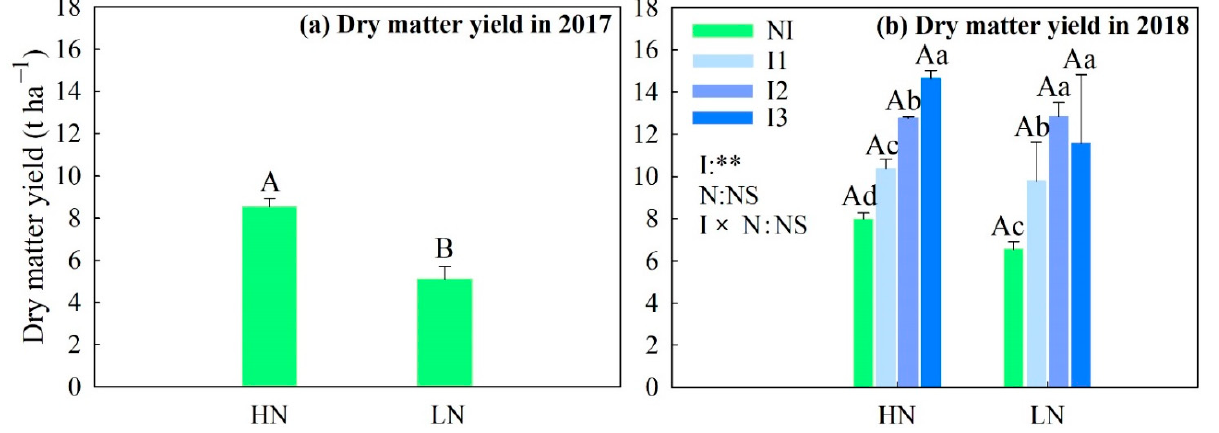
Figure 2. Oat dry matter yield under different irrigation and nitrogen applications in 2017 ( a ) and 2018 ( b ). HN—high nitrogen; LN—low nitrogen; NI—no irrigation; I1—irrigation only at flowering; I2—irrigation at tillering and jointing; I3—irrigation at tillering, jointing, and flowering. Different capital letters indicate a significant difference between different nitrogen treatments, and different lowercase letters indicate significant differences among different irrigation treatments under the same nitrogen level ( p < 0.05). I—irrigation; N—nitrogen; I × N—irrigation × nitrogen. Two stars mean that the effect is significant p < 0.01, and NS means the effect is insignificant. Error bars indicate one standard deviation from the mean.